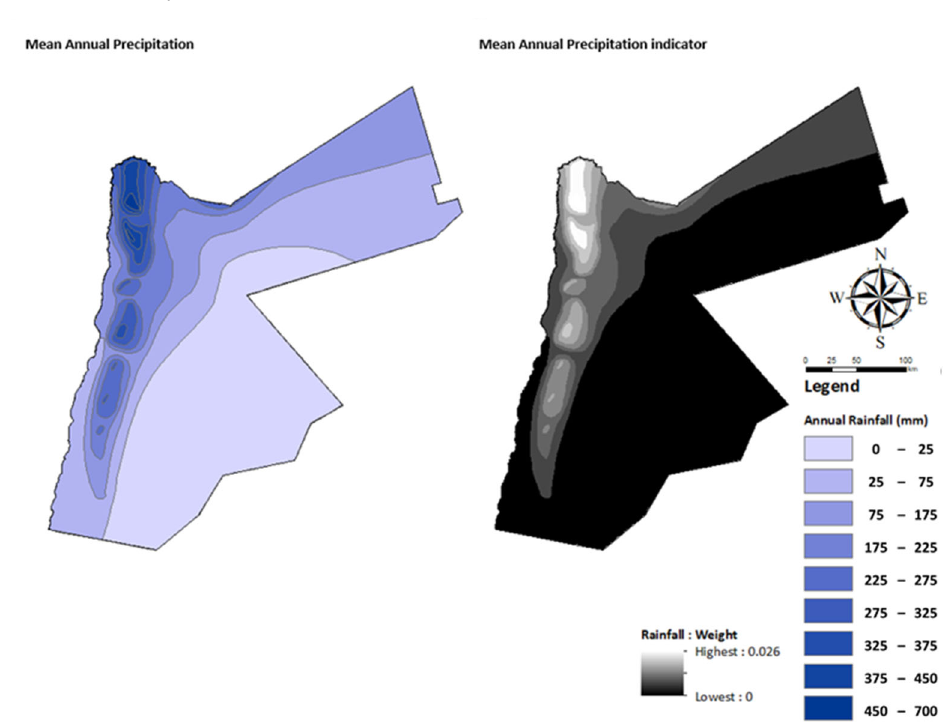
Figure 7. Density of GW Wells Indicator.